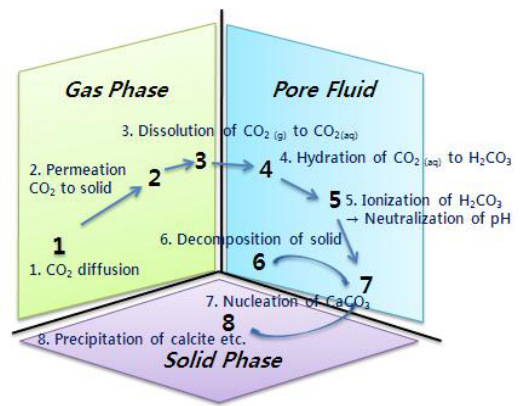
Figure 3. Schematic of accelerated carbonation in eight steps (modified from Marie [12]).